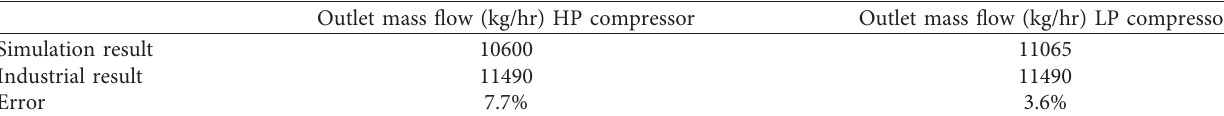
Table 7: Comparison of simulation results with compressor operating results at rpm